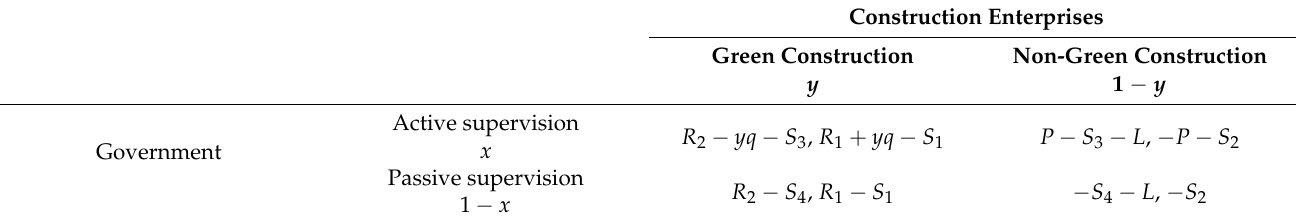
Table 5. The game payment matrix under dynamic reward and static